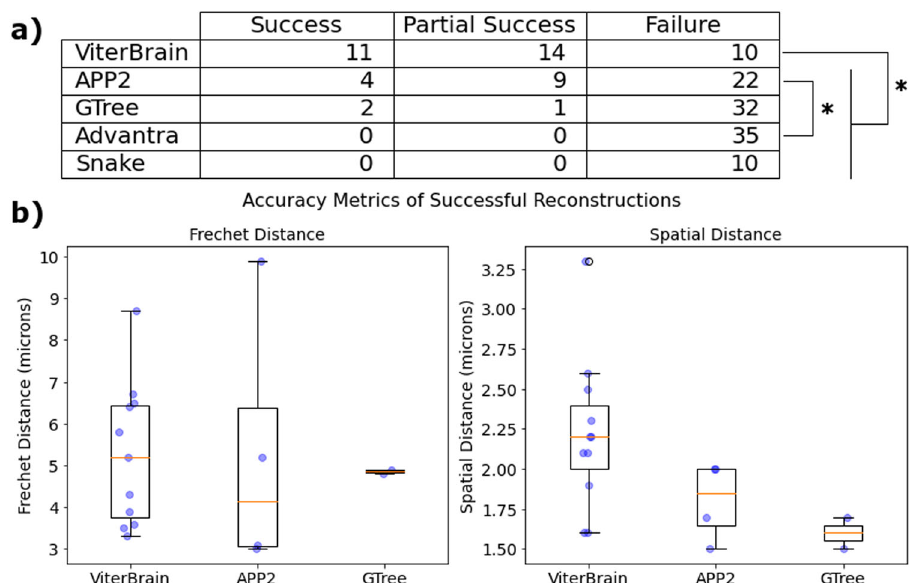
Fig. 7 Results of reconstruction algorithms on a dataset of 35 subvolumes of a MouseLight whole brain image. (Snake was only applied to 10 subvolumes due to incoherent results and excessively slow runtimes, see Fig. S4). Each subvolume contained a soma and part of its axon. The task was to reconstruct the portion of the axon that was contained in the image (no branching). First, the algorithms were evaluated visually and classi fi ed as successful, partially successful (over half, but not all, of the axon reconstructed), or failed. The table in panel a shows these results, along with markers showing statistical signi fi cance in a two proportion z-test comparing success rates of the algorithms at α = 0.05. For each successful reconstruction, we measured the Frechet distance and spatial distance from the manual ground truth in order to evaluate the precision of the reconstructions. These distances are shown as blue points in b , overlaid with standard box and whisker plots (center line, median; box limits, upper and lower quartiles; whiskers, 1.5x interquartile range; points,